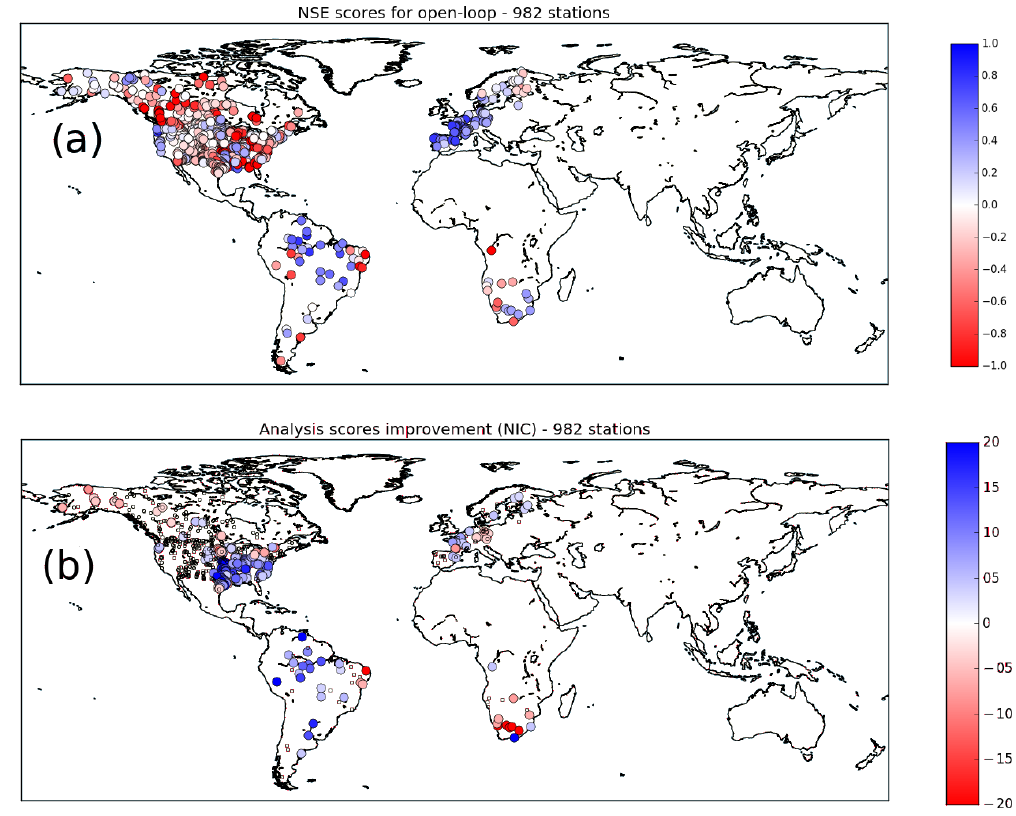
Figure 8. (a) Global map of Nash–Sutcliffe efficiency scores (NSE) between river discharge from LDAS_ERA5 open-loop and in situ measurements from the networks presented in Table S1 over 2010–2016. (b) Normalized information contribution scores (NIC, Eq. 2) based on NSE scores on river discharge. Small dots represent stations for which NICs are between [ − 3%, + 3%] (i.e. neutral impact from LDAS_ERA5 analysis), NIC values greater than + 3% (blue large circles) suggest an improvement from LDAS_ERA5 analysis over LDAS_ERA5 open-loop, while values smaller than − 3% (large red circles) suggest a degradation. Only stations where more than 4 years of data are available and with a drainage area greater than 10000km 2 are considered. Stations with NSE values smaller than − 2 are discarded, also leading to a subset of 982 stations